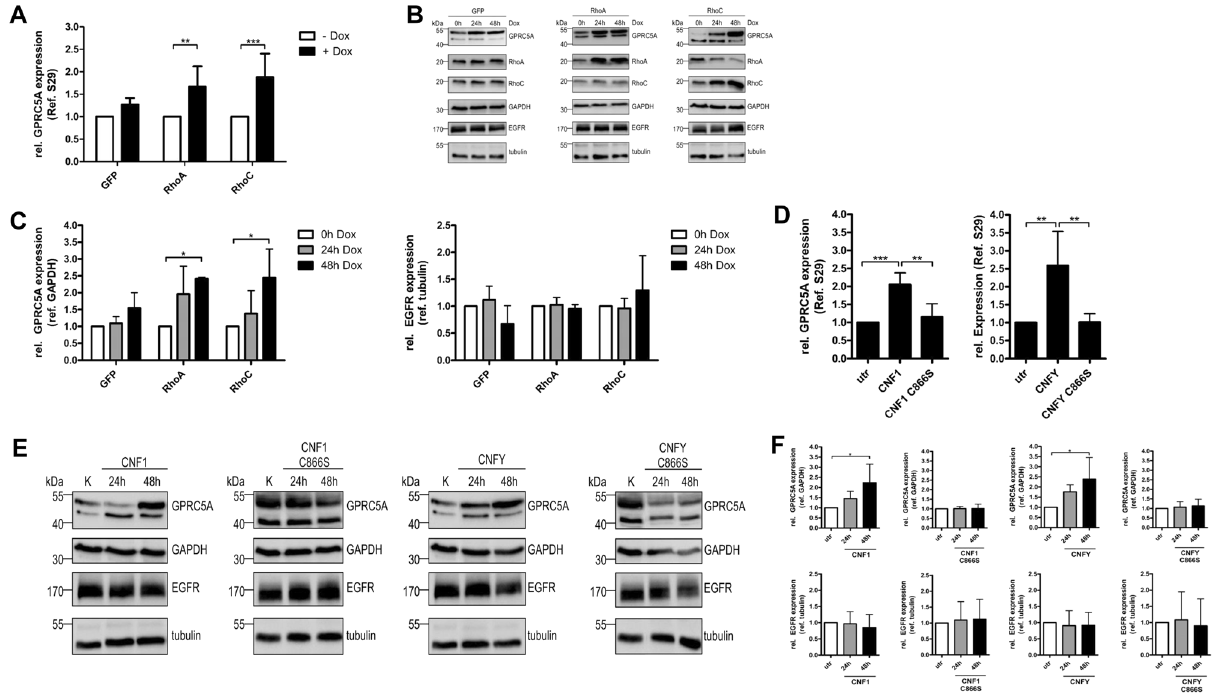
Figure 3. RhoA and RhoC induce the expression of GPRC5A. ( A ) GPRC5A mRNA level was measured by qRT-PCR following expression of RhoA, RhoC or GFP in MCF-10Atet cells (+ Dox) for 24 h. S29 was used as a housekeeping gene control. RNA levels after expression induction (+ Dox) were normalized to the untreated control (− Dox). Data of five independent experiments were quantified and analyzed using two-way ANOVA. ( B ) Representative Western Blot showing GPRC5A and EGFR protein levels following stimulation of RhoA, RhoC and GFP expressing MCF-10Atet cells for 0, 24 or 48 h with doxycycline (Dox). GAPDH and tubulin served as loading controls, respectively. Note that high expression of RhoC leads to decreased expression of RhoA, which has been described earlier 8 . ( C ) Quantification of B. GPRC5A protein level was normalized to GAPDH (left), EGFR protein level was normalized to tubulin (right). Data of three independent experiments were quantified and analyzed using two-way ANOVA. ( D ) GPRC5A mRNA level was measured by qRT-PCR after intoxication of MCF10A wild-type cells for 24 h with CNF1, CNF1 C866S, CNFY or CNFY C865S, respectively. S29 was used as a housekeeping gene control. RNA levels were normalized to the untreated (utr) control. Data of five independent experiments were quantified and analyzed using one-way-ANOVA. ( E ) Representative Western Blot (n = 3) showing GPRC5A and EGFR protein levels after intoxication with CNF1, CNF1 C866S, CNFY or CNFY C865S for 0, 24 or 48 h. GAPDH and tubulin served as loading controls. ( F ) Quantification of E. GPRC5A protein level was normalized to GAPDH (top), EGFR protein level was normalized to tubulin (bottom). The treatment with CNF1 and CNFY for two days GPRC5A expression was increased but the EGFR level was not affected. Data of three independent experiments were quantified and analyzed using one-way ANOVA. *p < 0.05, **p < 0.01, ***p <